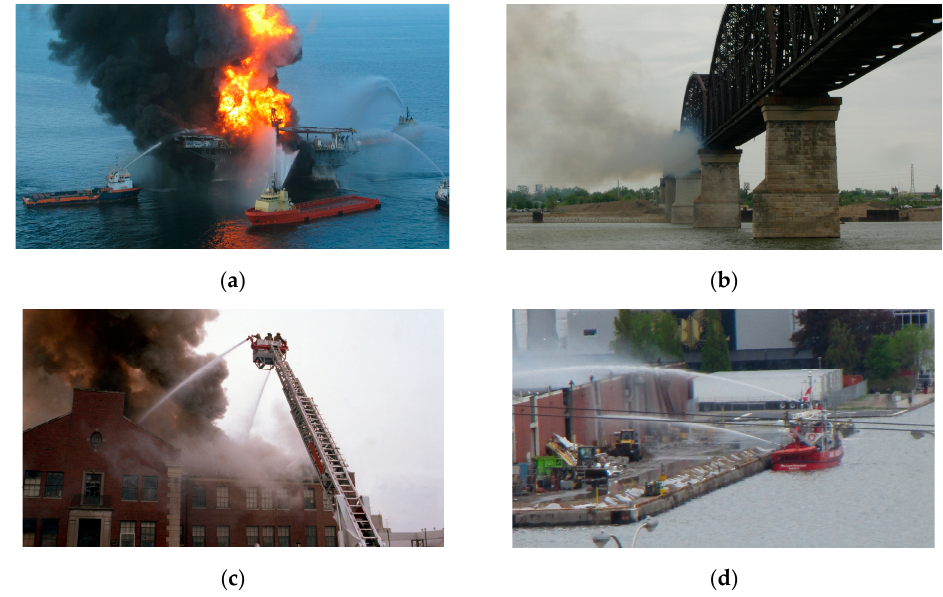
Figure 1. Application scenarios of the proposed systems: ( a ) Boat fire; ( b ) Fire on a bridge; ( c ) Fire in medium-rise buildings; ( d ) Fire at the border of a water area.